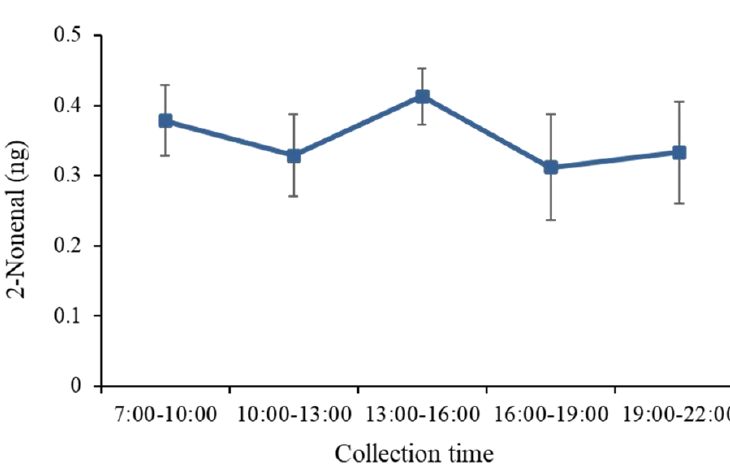
Figure 5. Circadian rhythm of 2-nonenal emission from skin (forehead) (average contents of 2-nonenal from three people).